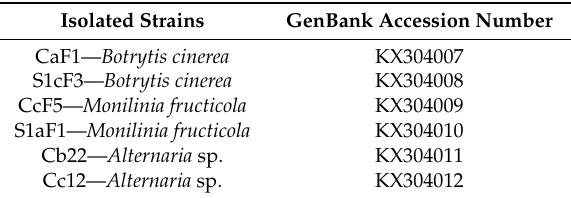
Table 1. GenBank accession numbers of ITS sequences of some pathogenic isolates from nectarines ‘Sweet Red’.